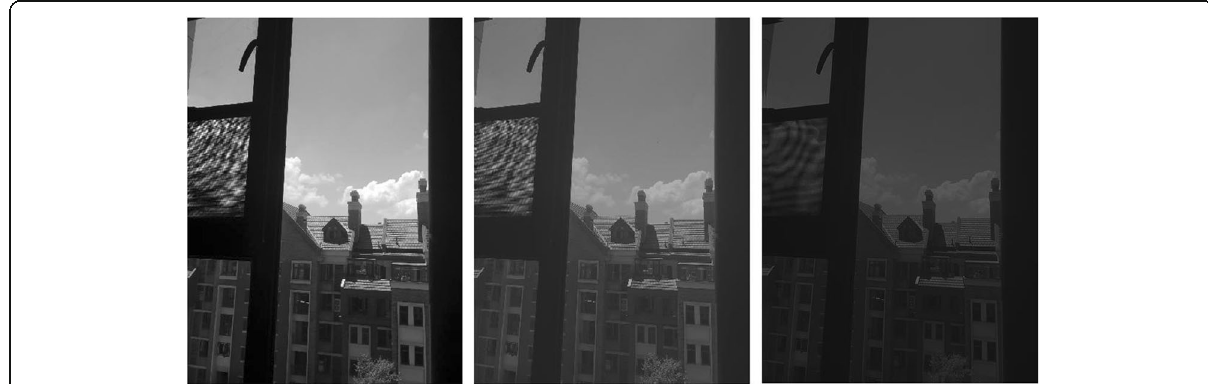
Fig. 4 Image comparison before and after compression. (left is the original image, the middle is the first compression, the right is the second